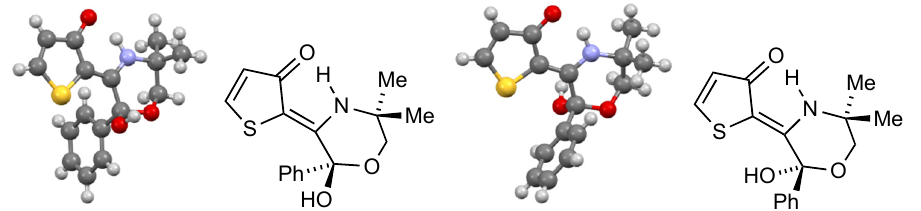
Figure 1. Conformations of the two enantiomeric molecules of 20 in the crystal.